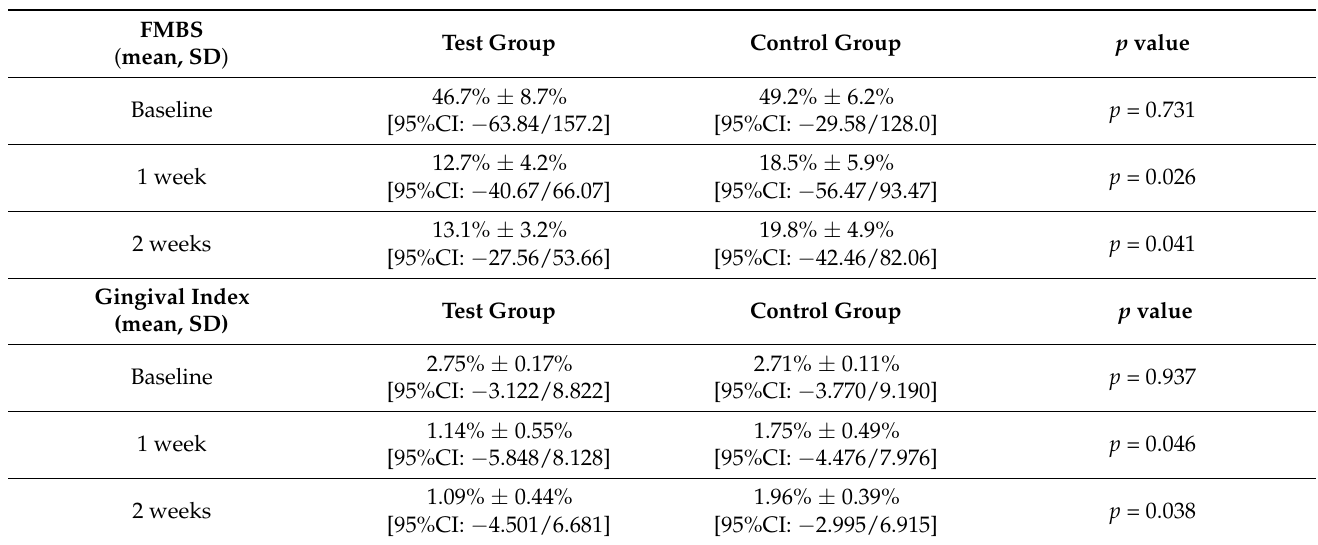
Table 2. FMPS, FMBS, and Gingival Index assessment of the Test and Control Group at the baseline, after 1 week, and 2 weeks.